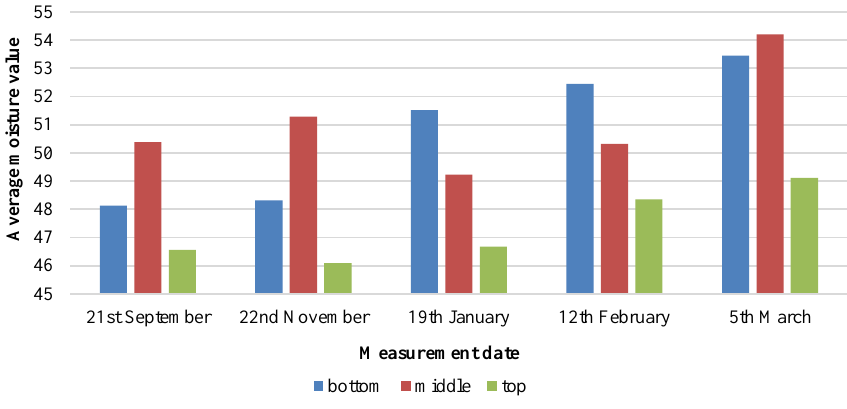
Fig. 5. Average moisture value changes for 20 cm depth measurements.